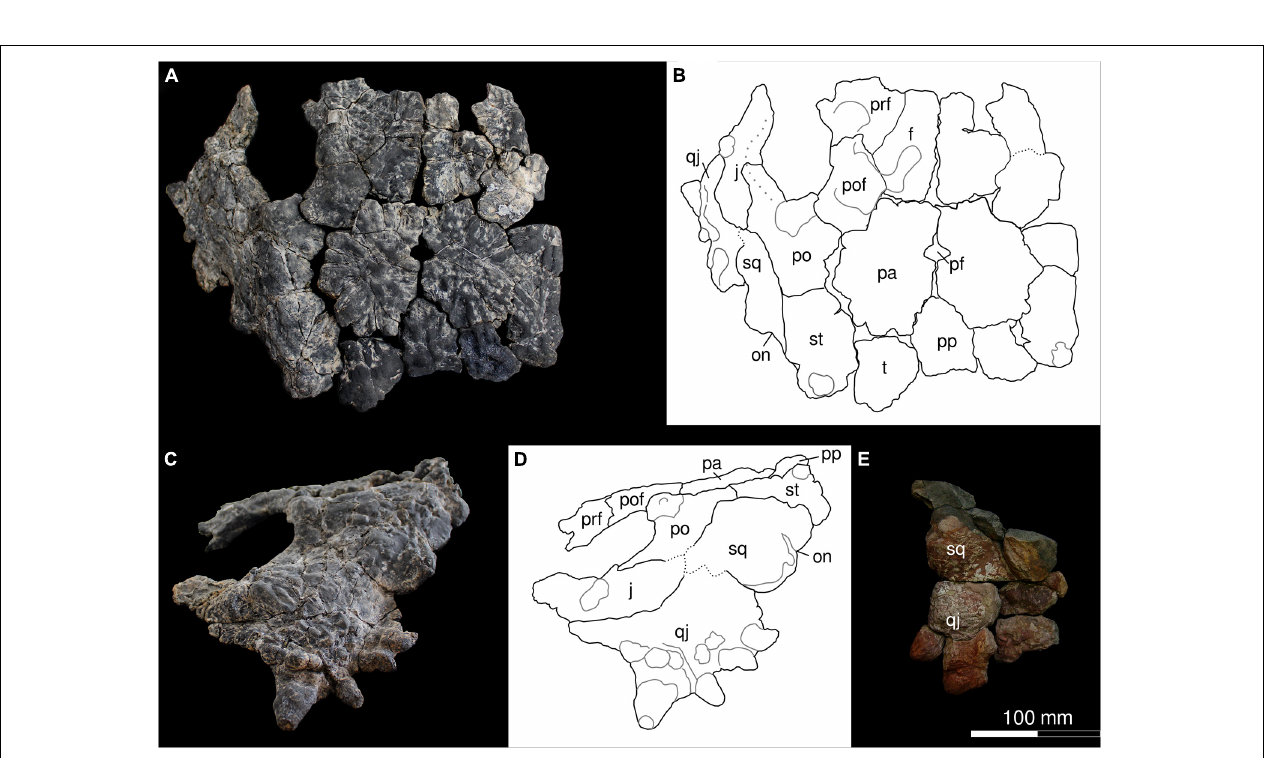
FIGURE 5 | Skulls of Provelosaurus americanus . (A–D) UFRGS-PV-0358-P, in (A,B) dorsal and (C,D) left lateral views. (E) UFRGS-PV-0359-P, portion of the temporal region in right lateral view. f, frontal; j, jugal; pa, parietal; pf, parietal foramen; po, postorbital; pp, postparietal; prf, prefrontal; pof, postfrontal; qj, quadratojugal; sq, squamosal; on, otic notch; st, supratemporal; t, tabular. Continuous gray lines represent major bosses.